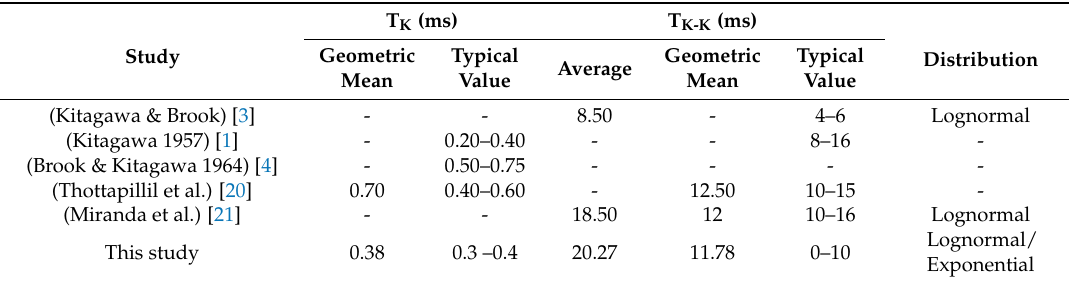
Table 4. Comparison of the results obtained for consecutive K-changes in the present study with the results obtained in previous studies. The mode range corresponds to the upper and lower limits of the histogram bin where the mode